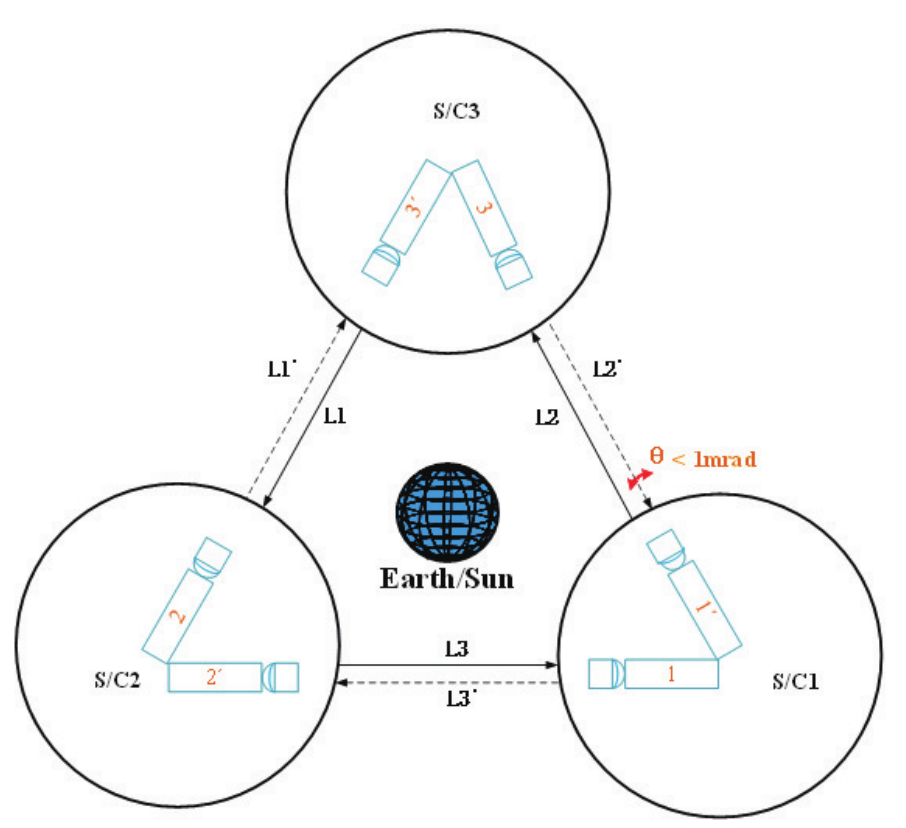
Figure 1. Laser link acquisition for gravitational wave